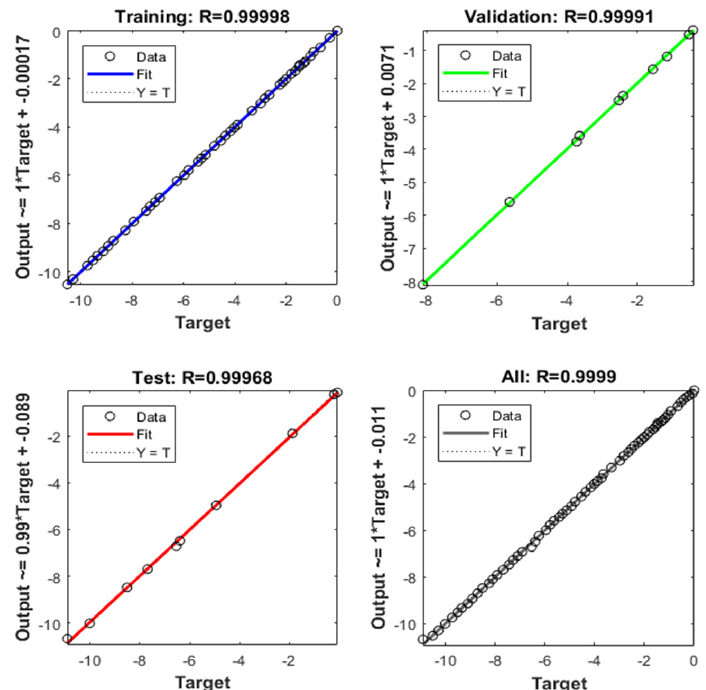
of the ANN method shows an error of not more than 1%. From the data from the two analyses and the load vs. displacement relationship pattern, it can be concluded that the sti ff ness of the BRC beam has similarities.